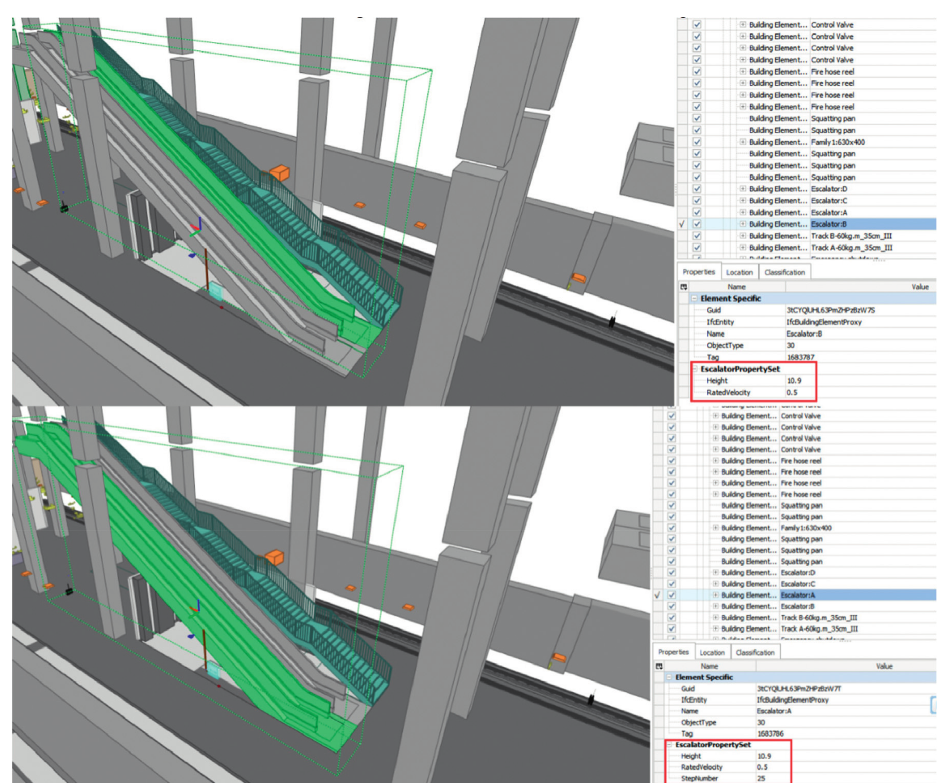
Figure 17: The property of Escalators A and B .